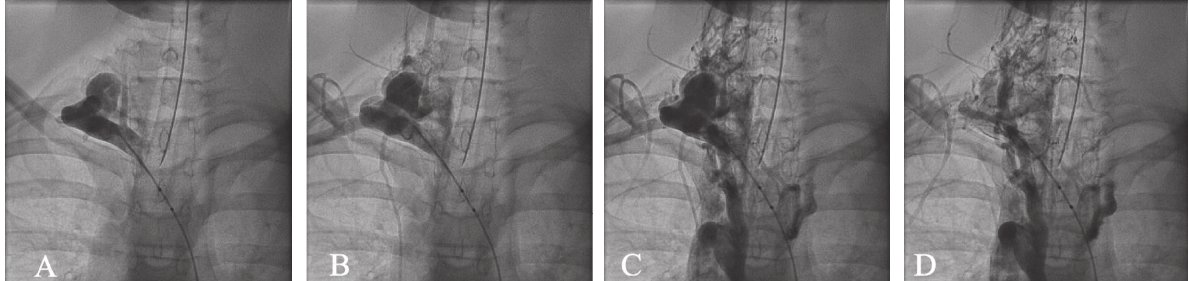
Figure 3: Serial images from right subclavian arteriogram show initial arterial phase (a, b) with subsequent venous phase of AVM (c,